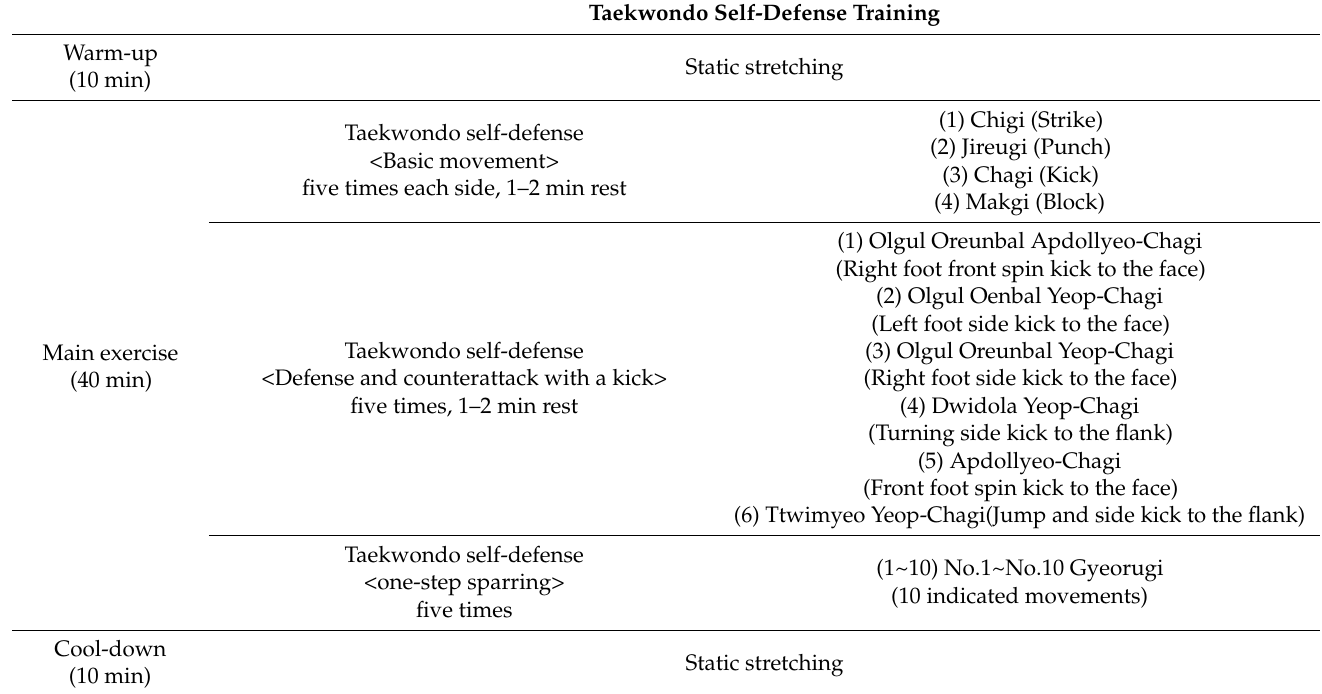
Table 3. Twelve-week Taekwondo self-defense training program. Taekwondo Self-Defense